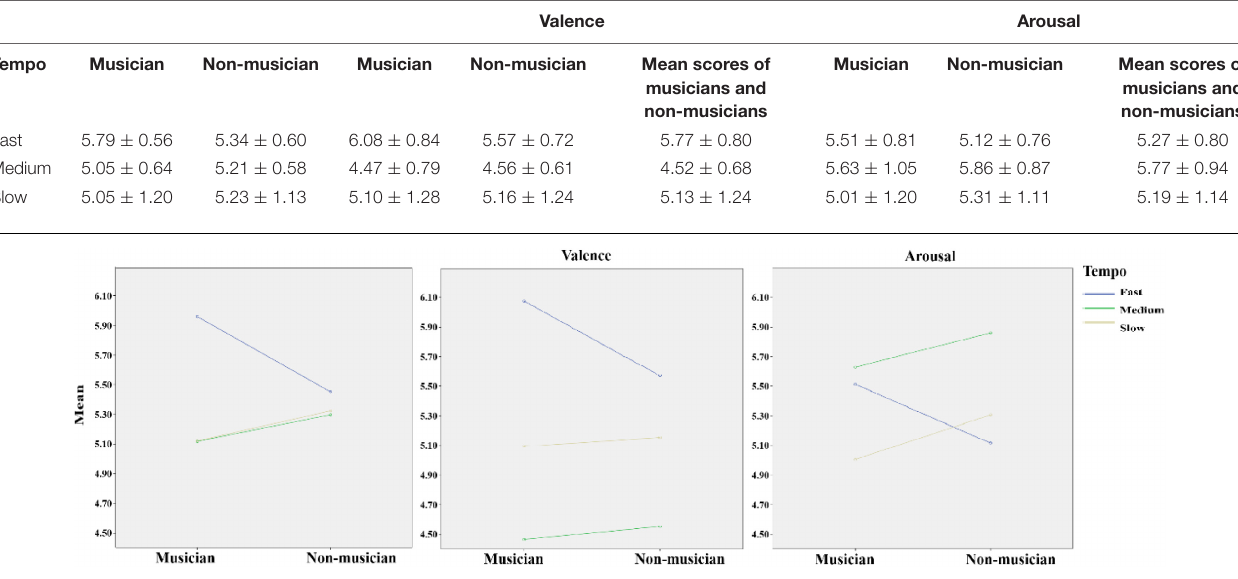
TABLE 1 | Average scores of three tempi in two emotional dimensions between musicians and non-musicians. Valence Arousal